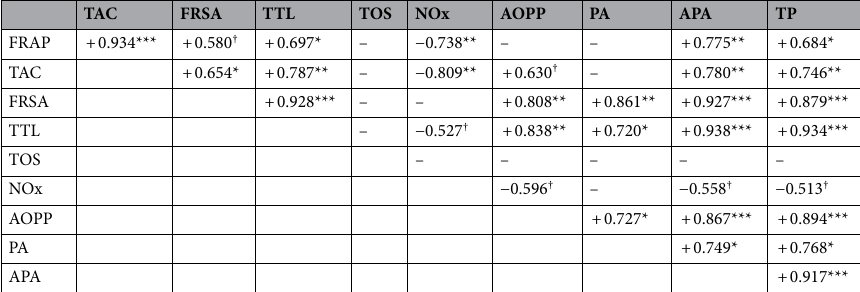
Table 3. Correlation matrix between oxidative profile and proteolysis regulator parameters in the seminal plasma of donkey stallions (n = 9). FRAP: ferric reducing ability of plasma; TAC: total antioxidant capacity; FRSA: free radical scavenging activity; TTL: total thiol levels; TOS: total oxidant status; NOx: nitric oxide metabolites; AOPP: advanced oxidation protein products; PA: protease activity; APA: antiprotease activity; TP: total protein. *, **, ***: indicate a statistic significance for P < 0.05, P < 0.01 and P < 0.001, respectively; † : indicate a tendency for P < 0.10.